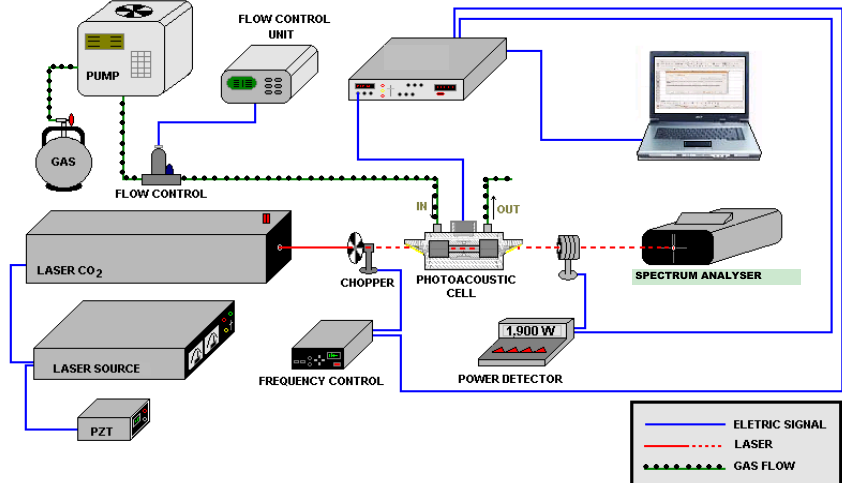
Figure 1. Scheme of the photoacoustic experimental setup.